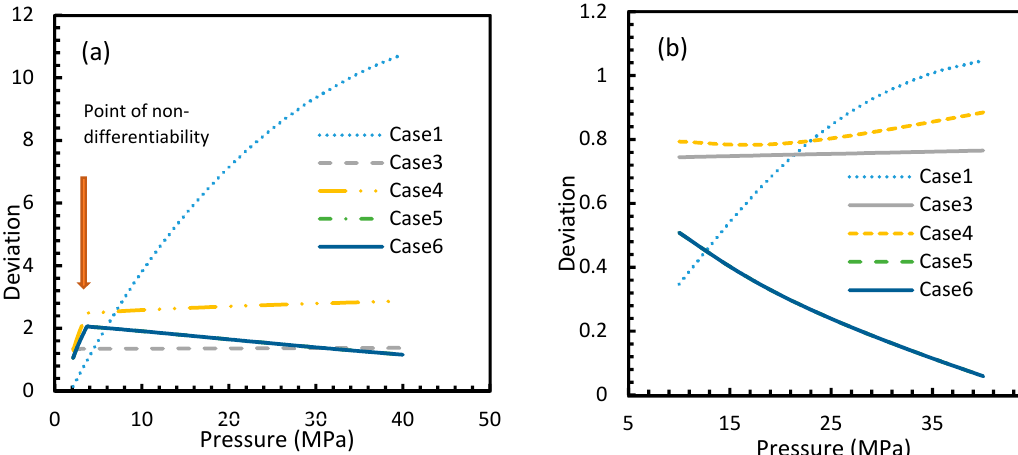
Figure 5. Deviations of gas concentrations of CO 2 ( a ) and CH 4 ( b ), calculated through considered cases from the reference case (Case 2). One can observe that the point of non-differentiability was sharply pronounced by these profiles. The overall deviation of Case 4 from Case 3 is negligible within the domain of operational conditions when compared to the rest. Case 1 showed an exponential increase in deviation from Case 2 with pressure, while the rest showed either asymptotic with less magnitude or decremental deviations with pressure from Case 2.